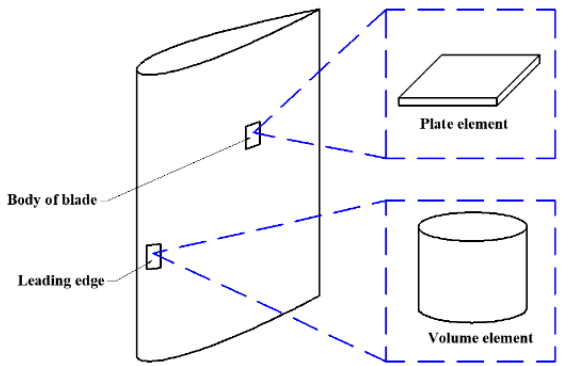
Figure 2. Simplification model of the wind turbine blade. The formation of ice is a phase change of water from liquid to solid as the temperature falls below zero degrees Celsius. After phase change, the ice is frozen together with the substrate material. Therefore, the iced body is similar to a composite material. In general, there are three basic categories of deicing systems, which are the mechanical deicing system, the thermal deicing system, and the chemical deicing system. For the mechanical deicing system, the principle of the deicing system is to break the adhesive bond [22]. Many years ago, researchers found that the adhesion strength of ice is lower in shear than in tension [23]. Similarly, in a previous study, it was also validated that the key factor of breaking the adhesive bond is shear stress [24]. Therefore, researchers selected shear stress as the deicing parameter for the mechanical deicing system. In this paper, the ultrasonic deicing method used is a mechanical deicing system. Its principle is shown in Figure 3a. As shown in Figure 3a, when the PZT patch (piezoelectric ceramic) is excited by excites the iced aluminum alloy plate to vibrate and deform. Then, the mechanical shear stress generates due to bending deformation at the adhesive interface. When mechanical shear stress is higher than the adhesive shear stress of ice, the ice can be